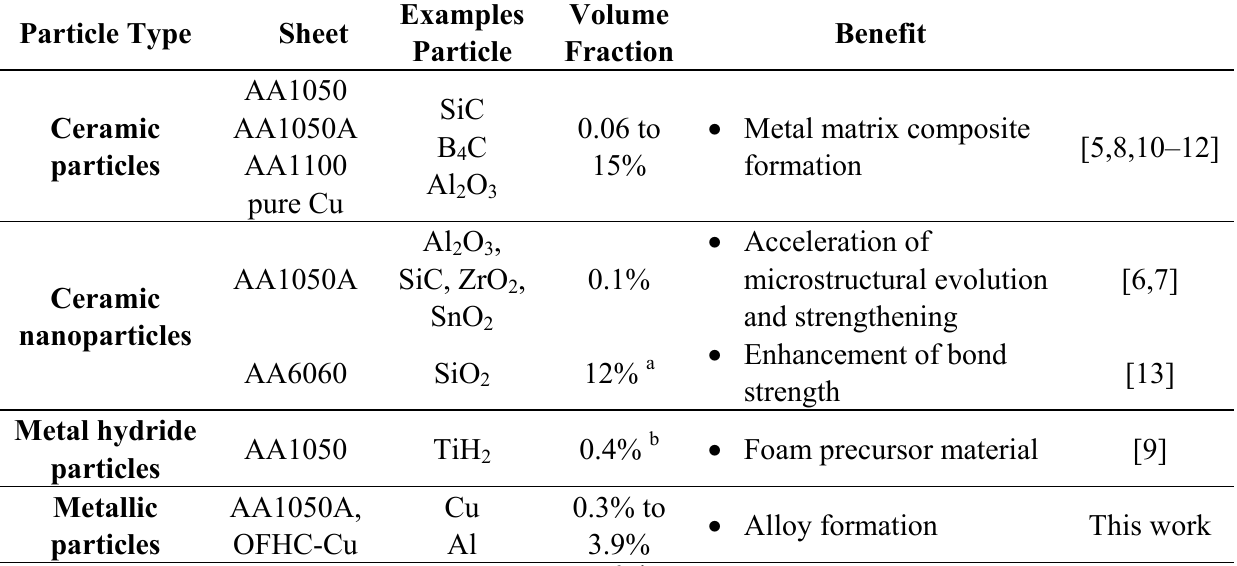
Table 1. Review of published applications of particle reinforcement during accumulative roll bonding